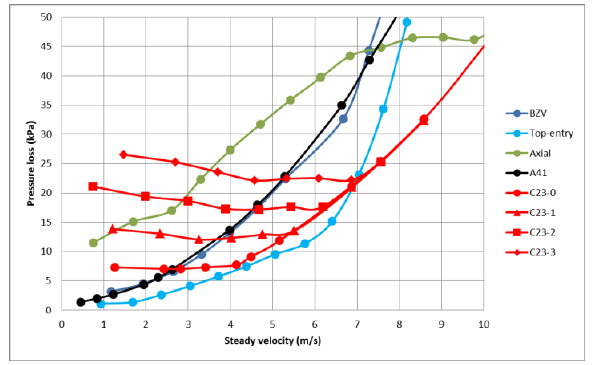
Fig. 12. Static properties – pressure loss dependence on mean water flow